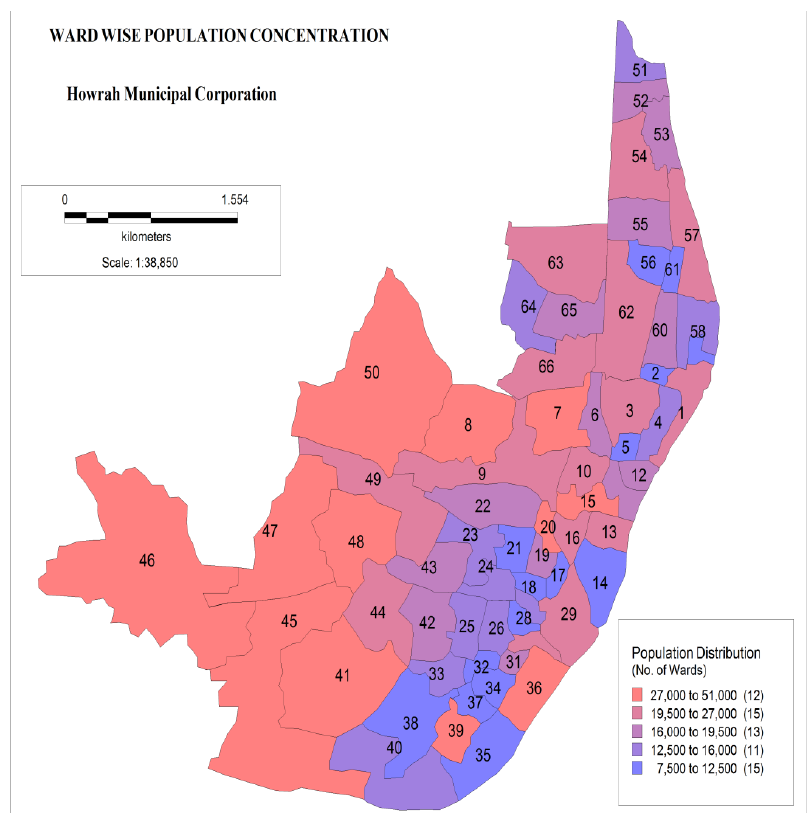
Figure 9. Ward wise population distribution of HMC. Table 3. Sub-factors taken for the study.